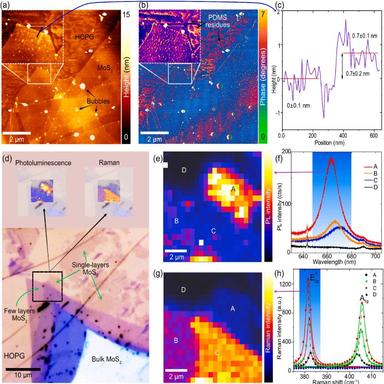
PL and Raman maps of MoS2 on HOPG. a) AFM topography and b) phase images. c) Single-layer height profile of the regions visible in d) the optical microscopy image. The red lines are linear fits for the substrate and MoS2 monolayer profile with the fitting errors. e) PL map with regions of interest labeled: Amonolayer MoS2, B-bilayer MoS2, C-trilayer MoS2, and D-HOPG. f) PL spectra from different regions of interest. g) Raman intensity map. h) Raman spectra from different regions. (For interpretation of the